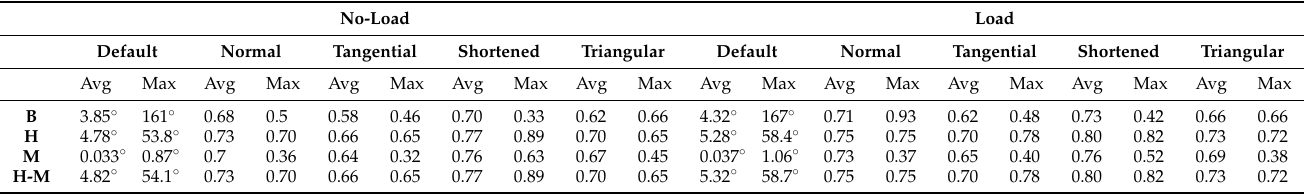
Table 4. Angular dependency of magnetic flux density B , magnetic field strength H and magnetization M for the linear machine due to pole shoe alterations under no-load and load. For the design alterations, the inclination angels are given as a fraction of the respective inclination angle for the default case. The pole shoe alterations are illustrated in Figure 6.